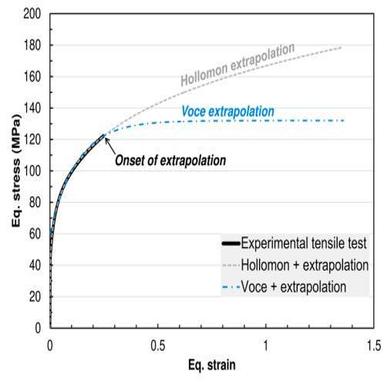
Experimental tensile test and hardening model flow curves.